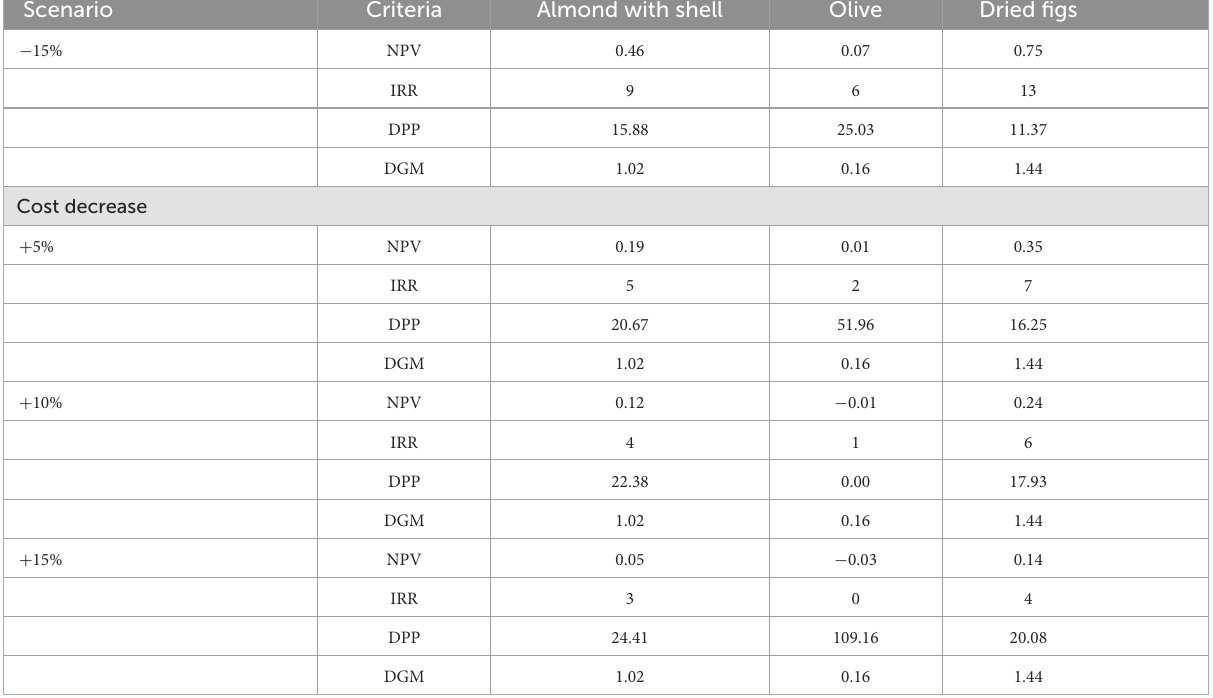
Changes in discount rates relative to the baseline scenario show higher values for all the criteria analyzed with the discount rate of 1.6% and lower values with the discount rate of 2.4%. The criterion that varies the most in all scenarios is NPV, with the discount rate of 1.6% registering + 50% in olive groves, + 15% in almond groves, and + 11% in fig groves. With a discount rate of 2.4% for all scenarios, there is a reduction in NPV, respectively − 50% in the olive grove, − 15% in the almond grove, and − 11% in the fig grove. Regarding “positive variances,” the simulations were carried out in terms of price increases and cost reductions. These variations as argued by Strano et al. (2015) should be taken into account due to the volatility of prices and inputs that could happen in the market depending on the current economic conditions. From the elaborations, it is possible to note, as was obvious, that in all the scenarios, the criteria considered remain positive for the hypothesized scenarios. However, from the analysis of the deviations, it emerges that, ceteris paribus, the change in price considering an increase of 5% has a more significant impact on the almond and fig scenario with a deviation from the base scenario of 34 and 24%, respectively, while 50% on the olive tree, while the 5% cost reduction shows a 24% difference for the almond tree, 22% for the fig, and 90% for the olive tree. Similar results are recorded by analyzing the profitability of the investment in terms of IRR. However, as discussed by Strano et al.